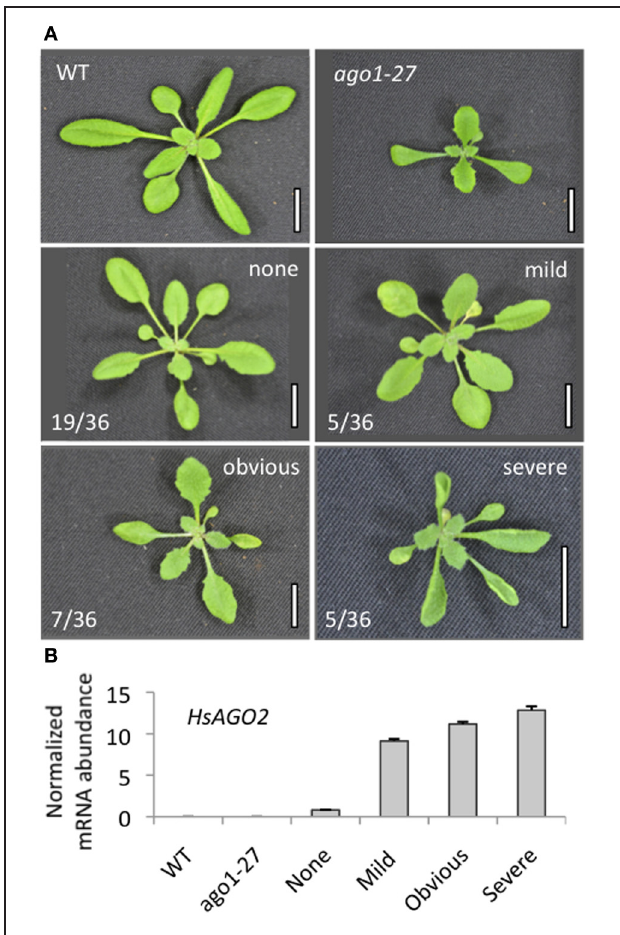
FIGURE 1 | Expression of HsAGO2 generates morphological defects in Arabidopsis. (A) 22-day old primary transformants for the 35S:HsAGO2 construct were categorized based on the apparent severity of their morphological phenotypes. Increased leaf serration distinguished “mild” phenotypes from wild type (WT), “obvious” phenotypes were characterized by broadened leaves, serration, accelerated senescence and some upward leaf-curl, while phenotypes considered “severe” were distinguished by strong upward leaf-curl in addition. Scale bars represent 10mm. (B) The abundances of HsAGO2 mRNA was measured in total RNA from sample pools composed of 4–8 transformants, 22-days old, from each morphological category. Wild type (WT) and ago1–27 plants, grown in parallel, were included as controls. All measurements are normalized to CYCLOPHILIN mRNA. Data is averaged from three technical cDNA replicates, each of which comprised triplicate measurements, and error bars depict standard error of the